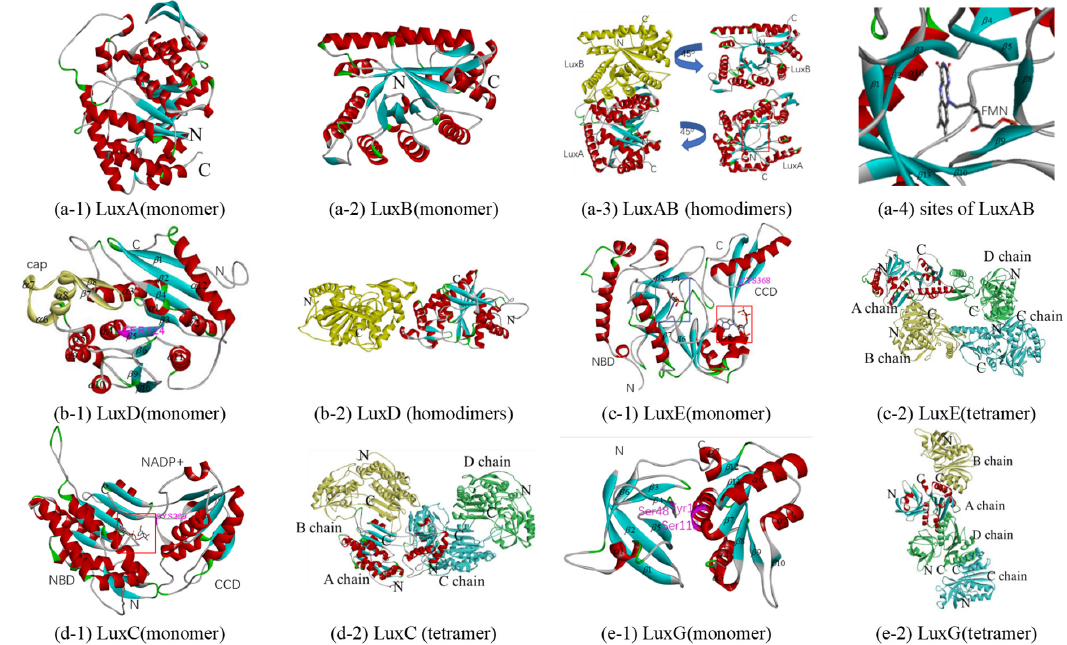
Figure 5. Predicted structure–function diagram of enzymes or their subunits in bacterial bioluminescence. ( a-1 ), ( a-2 ), ( b-1 ), ( c-1 ), ( d-1 ) and ( e-1 ) are the ribbon diagrams of monomers; ( a-3 ), ( b-2 ), ( c-2 ), ( d-2 ) and ( e-2 ) are the ribbon diagram of oligomers, where red box refers to predicted binding-site and purple refers to the residues of the site; ( a-4 ) is the possible conformations of FMN and its surrounding residues.